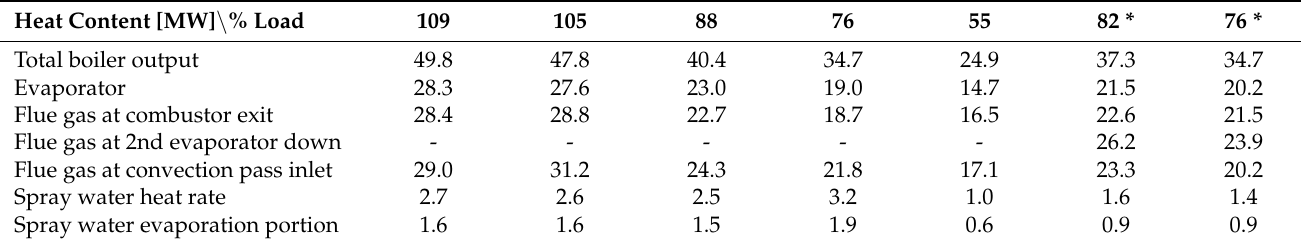
Table 4. Heat content of flue gas and boiler units according to boiler location (using measured